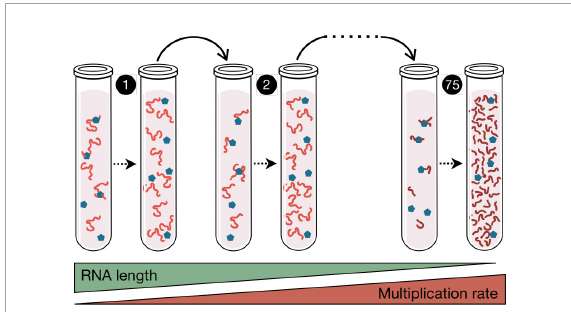
FIGURE1 Spigelman’s Monster. In this experiment published in 1967, the RNA from phage Q β (red lines) and the enzyme responsible for its copy (blue pentagons) were incubated in the presence of nucleotides, and subjected to in vitro replication. The products of each polymerization reaction were serially transferred to new tubes. After 75 of these transfers, 83% of the RNA genome was eliminated, which in turn increased the multiplication rate of the RNA population. This seminal paper by Mills et al. (1967) demonstrated that darwinian evolution can occur in a test tube. Similar serial transfers experiments are used in the study of virus